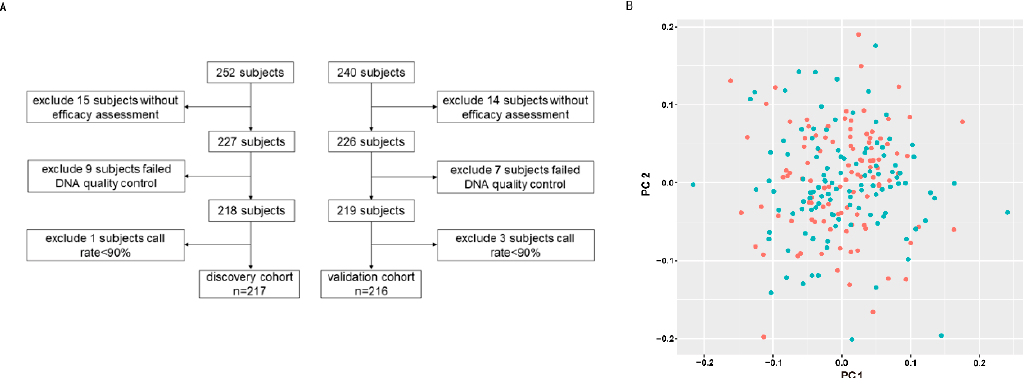
Figure 1. Sample screening and quality control. ( A ) Sample filtering for discovery and validation cohorts. ( B ) The PCA of the discovery cohort. The red spots represent sensitive patients and the green spots represent resistant patients. The horizontal and vertical coordinates are the PC1 and PC2 values for each sample.